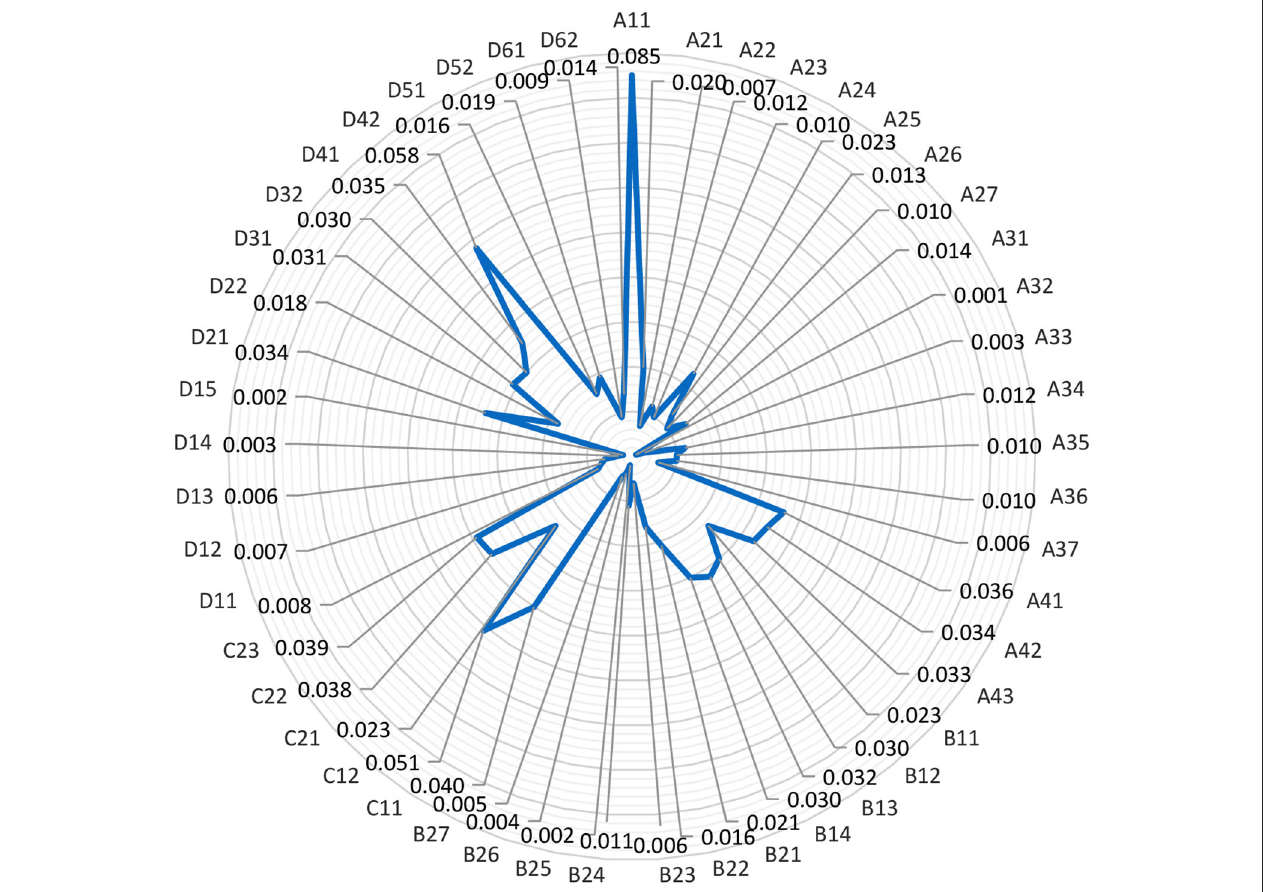
FIGURE 2 | The evaluation system of the national fitness development index and the weight value of each evaluation